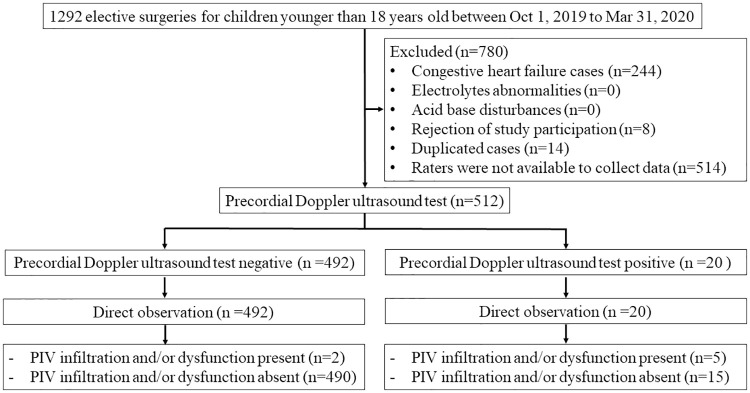
Flow diagram of participants.